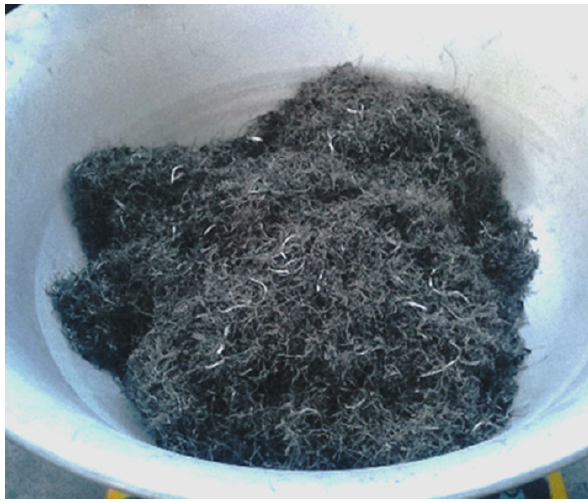
Figure 1. The aggregate fraction analysis.